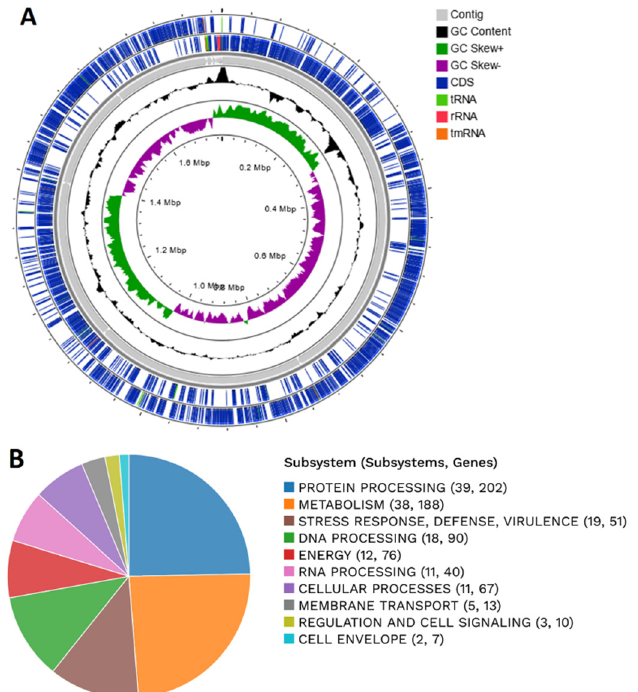
Figure 1. ( A ) Circular graphical map of L. johnsonii CNCM I-4884 genome. From outer to inner rings, CDS on the forward strand, CDS on the reverse strand, contigs, GC content and GC skew. ( B ) An overview of the RAST annotation and subsystems.